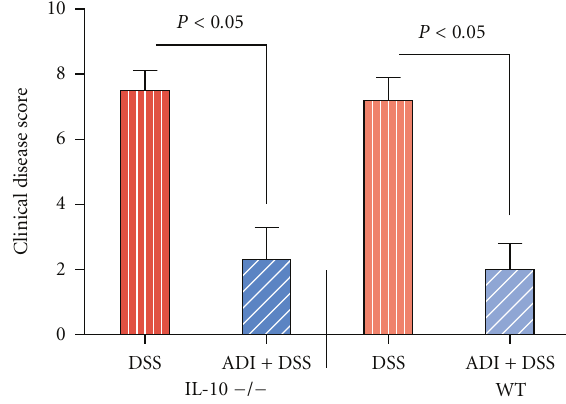
Figure 1: E ff ects of ADI-PEG therapy on the clinical disease index in DSS-induced acute colitis. ADI-PEG was administered i.p on day 0 and day 5. Clinical disease index was determined by parameters as means for extent of weight loss, presence of diarrhea, rectal bleeding, prolapse, and anemia ( n = 6/group). ADI-PEG markedly decreased the clinical disease index in WT and IL-10-deficient colitic